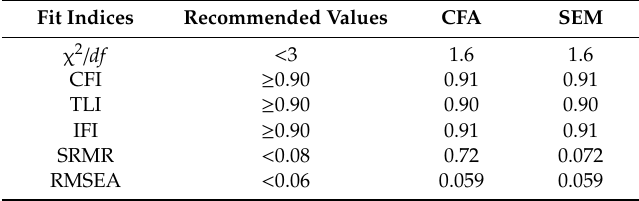
Table 1. Fit indices for the tested models.